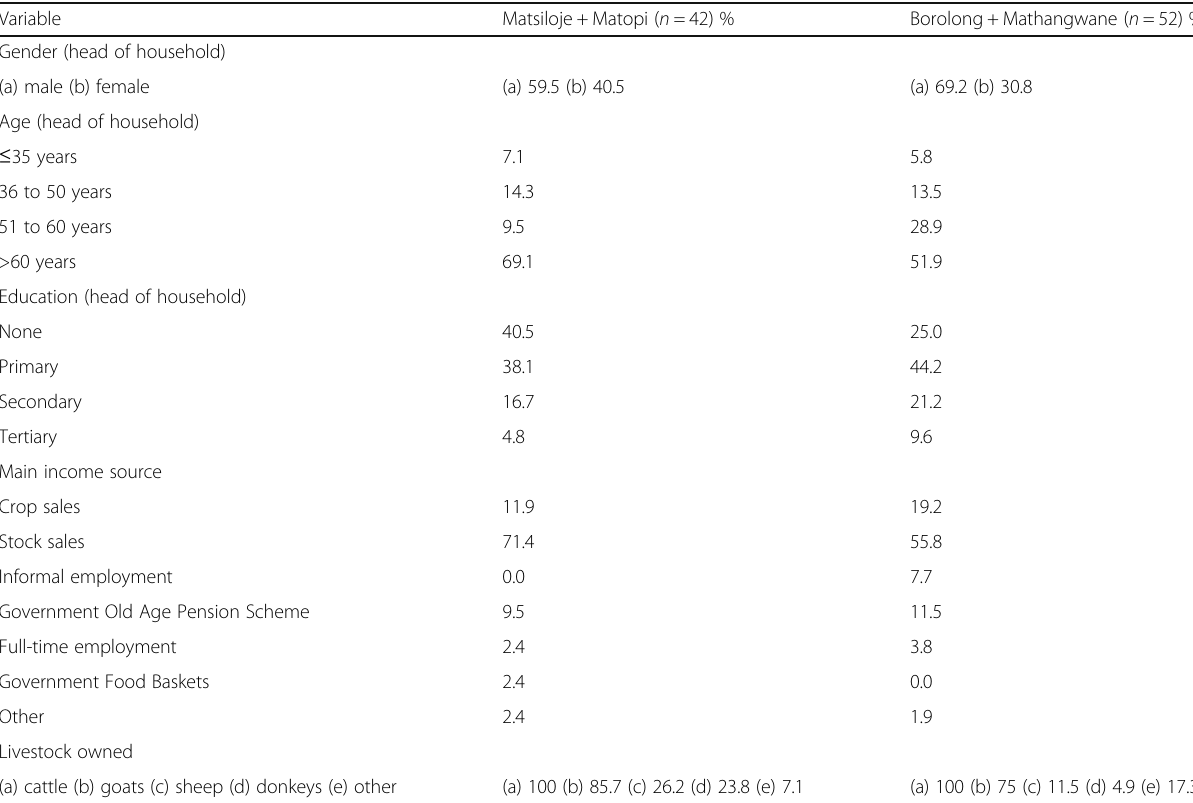
Table 1 Characteristics of households in the study area (Zone 6), Botswana